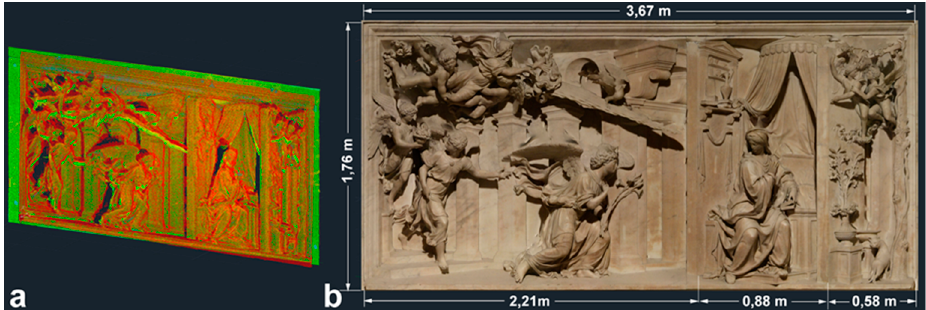
Figure 3. Processing of the survey made on the sculpted panel of the Annunciation: ( a ) union of the point clouds obtained from the survey (laser scanner data in green, photogrammetric data in red), ( b ) orthographic projection of the texturized mesh resulting from the integrated